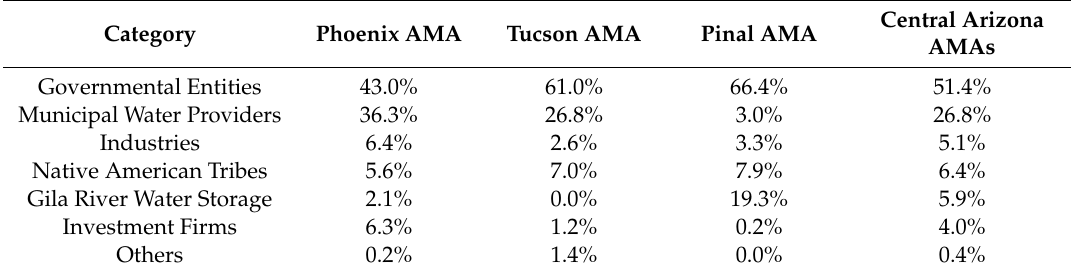
Table 1. Long-term storage credits owned by category in 2016 in Central Arizona Active Management Areas (AMAs). Data source: